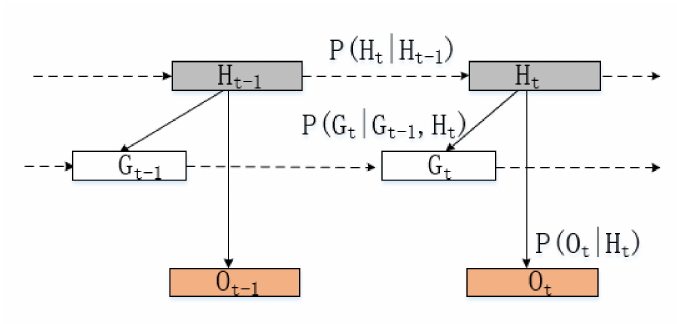
Figure 7. Dynamic Bayesian networks for intention recognition.